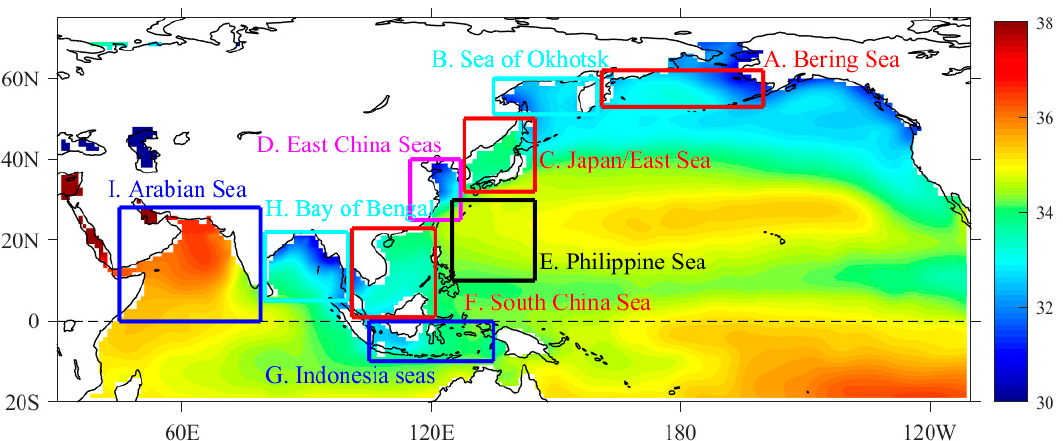
Figure 1. Study regions of the Asian Marginal Seas (AMSs), with a background color map representing the distribution of the climatological annual mean sea surface salinity (unit: psu). The study regions are indicated by boxes, as follows: A. Bering Sea; B. Sea of Okhotsk; C. Japan/East Sea; D. East China Seas (including the East China Sea, the Yellow Sea, and the Bohai Sea, ECSs); E. Philippine Sea; F. South China Sea (SCS); G. Indonesian Seas; H. Bay of Bengal; and I. Arabian Sea.